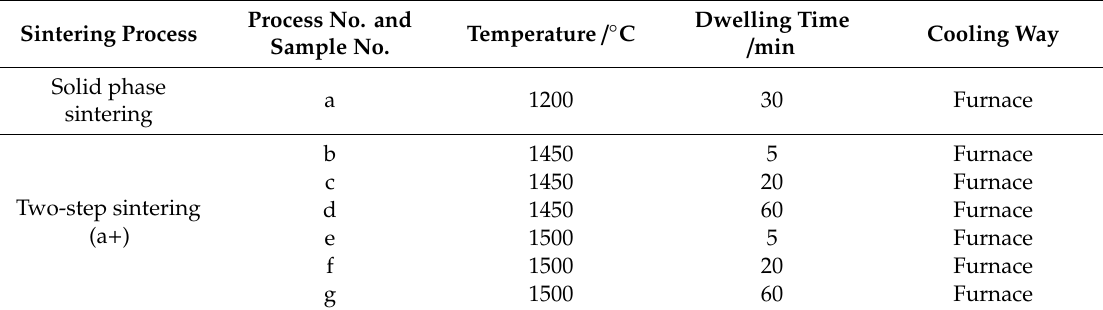
Table 2. Technology parameters of two-step sintering.